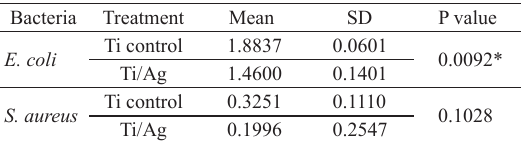
Table 2. Optical density for growth analysis of E. coli and S. aureus bacteria on Ti and Ti-Ag samples, after 16h time incubation at 37 o C. Bacteria